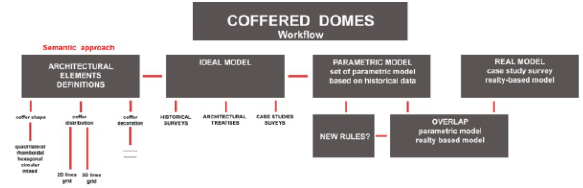
Figure 3. Coffered domes: process for parametric objects library